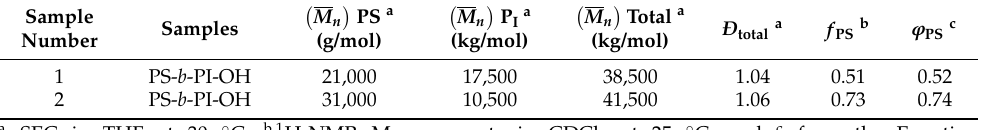
Table 1. Molecular characterization results for the linear diblock copolymers of the PS- b -PI-OH type. Sample